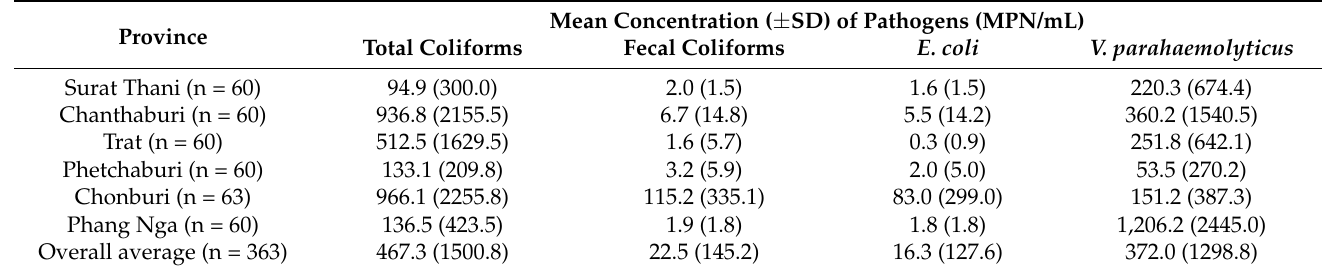
Table 5. Mean concentration and SD of total coliforms, fecal coliforms, E. coli , and V. parahaemolyticus in coastal water samples (n = 363) from oyster production regions in